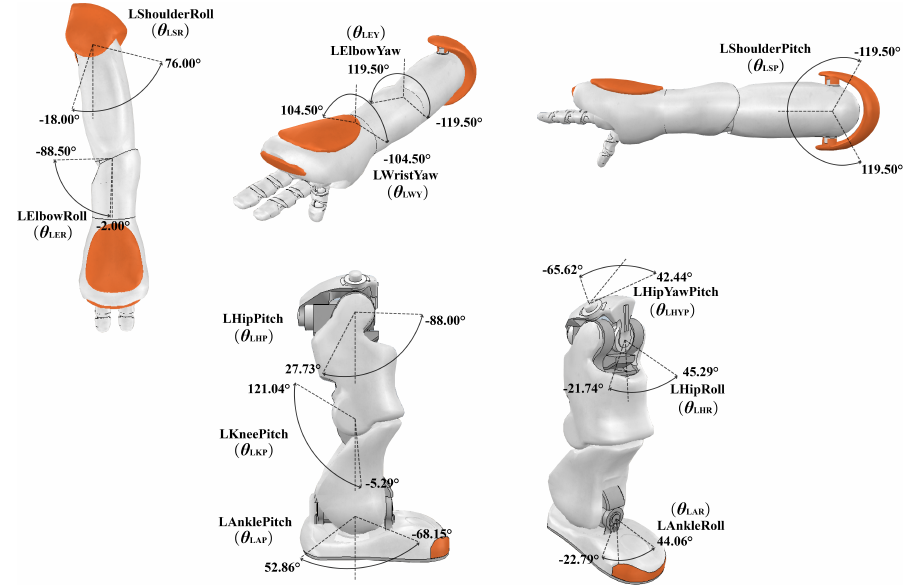
Figure 3. Upper- and lower-limb joints and joint angles of the NAO robot.